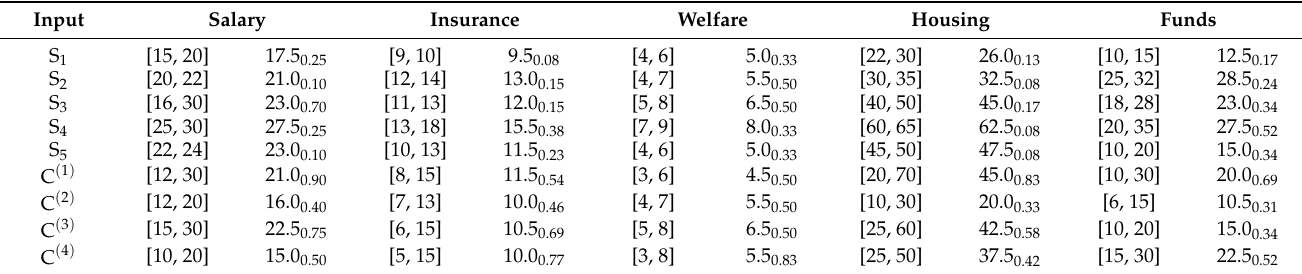
Table 1. Evaluation value and reference point value under input indicators (unit: CNY 10,000).